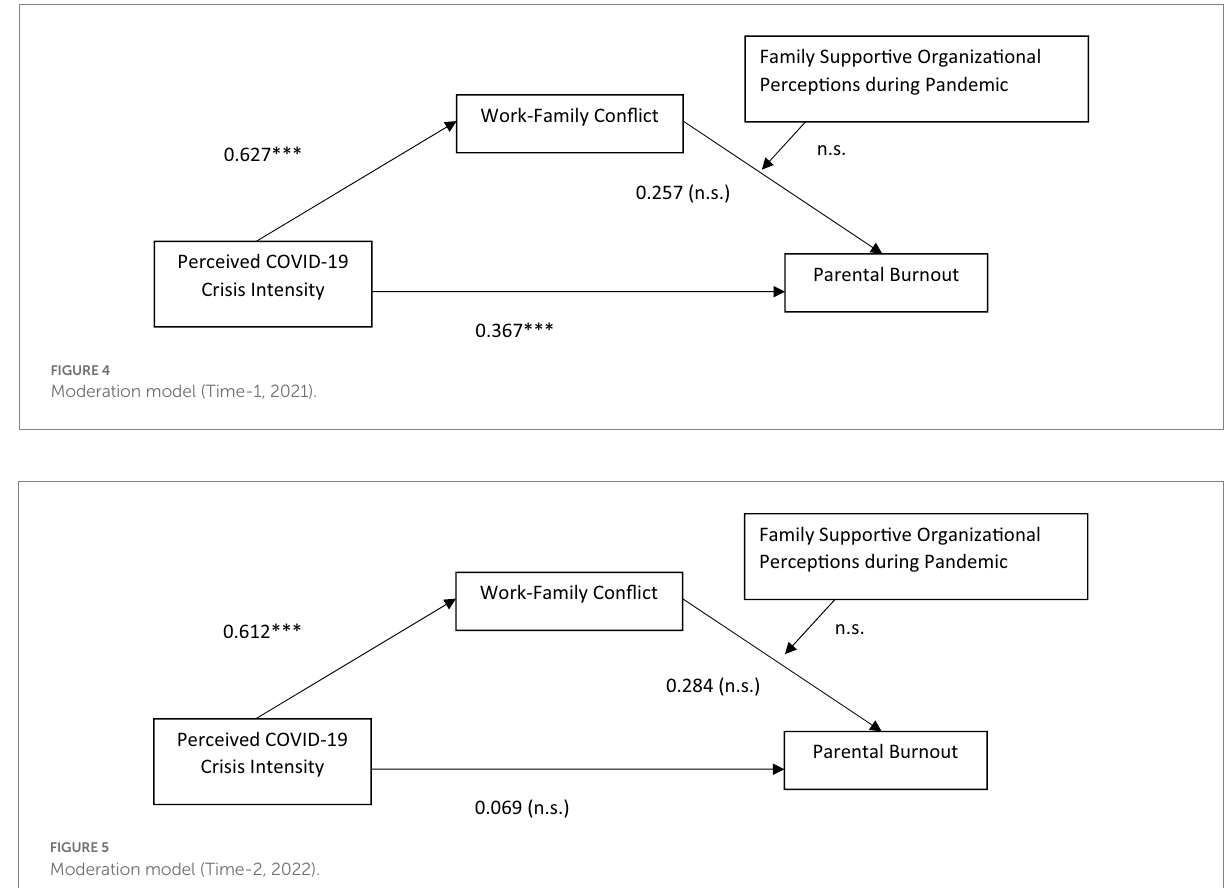
FIGURE 5 Moderation model (Time-2,